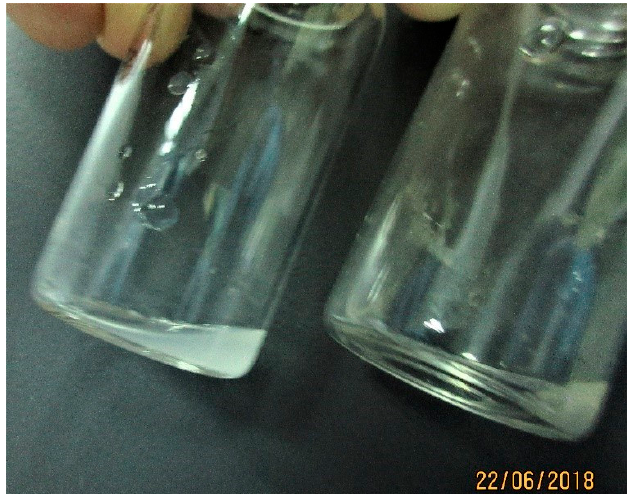
Figure 2. Semen collected from Leopard 1 in June 2018 showing the first (left) and subsequent collection (right). Ten ejaculates obtained from Leopard 1 ranged from 250 µ L to 560 µ L, in contrast to leopard 2, 115–295 µ L (Supplementary File 1). As an average, sample volumes were similar between Leopard 1 and Leopard 2 (Table 3). However, all samples from Leopard 1 were ≥ 250 µ L, 90% exceeded 300 µ L, 40% were > 400 µ L, and 20% were > 500 µ L. In contrast, 67% of samples from Leopard 2 were between 250 and 295 µ